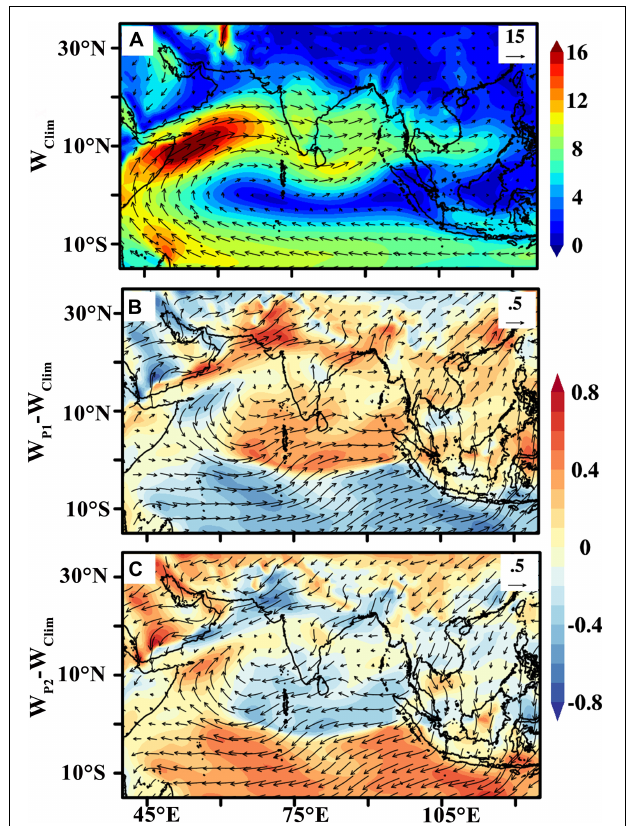
FIGURE 10 | The wind climatology and anomalies at 850 hPa (colored shading; Unit: ms - 1 ) superimposed with wind vector (Unit: ms - 1 ) during southwest monsoon season (A) Climatology averaged over 1985–2015; (B) Anomalies for P 1 period (1985–1999) and (C) Anomalies for P 2 period (2000–2015) from the